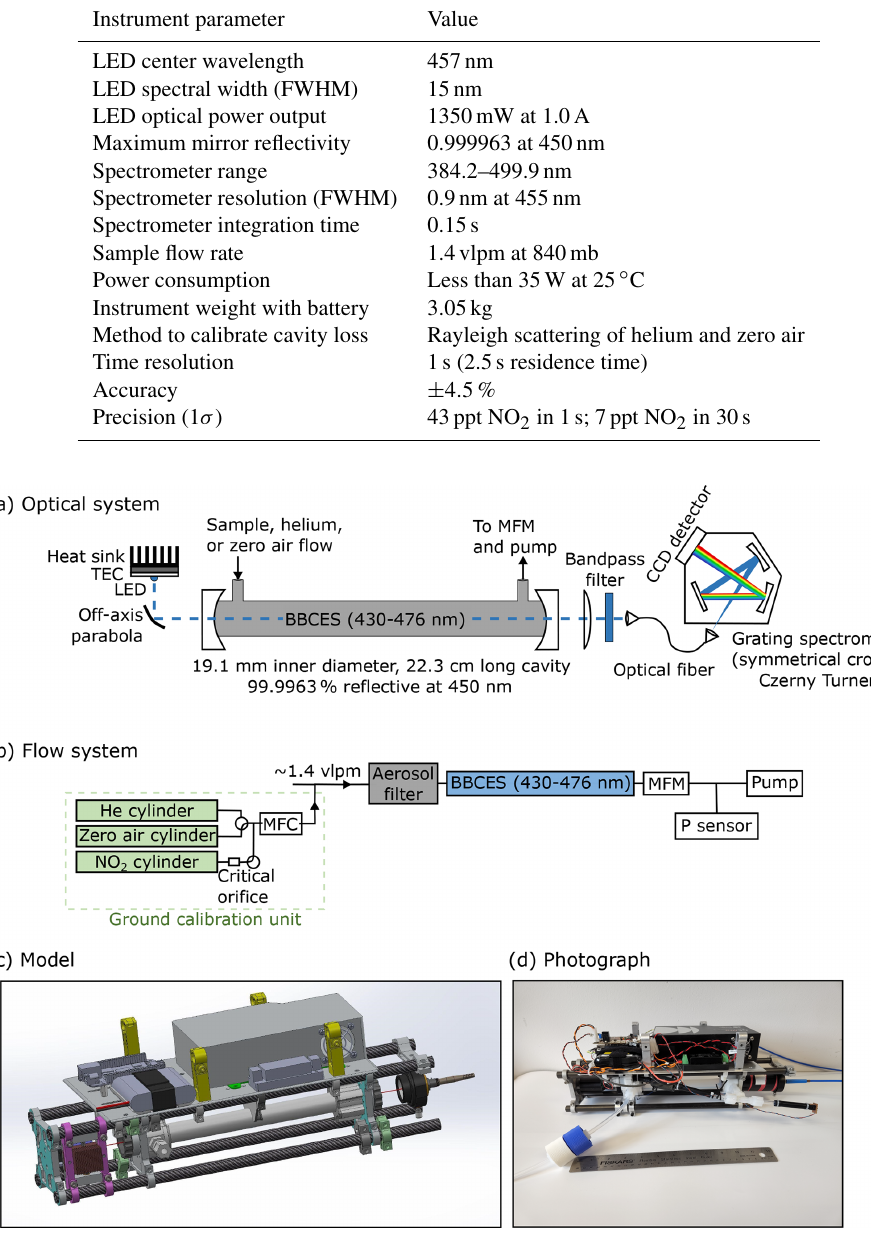
Table 1. Specifications of the lightweight mACES instrument.